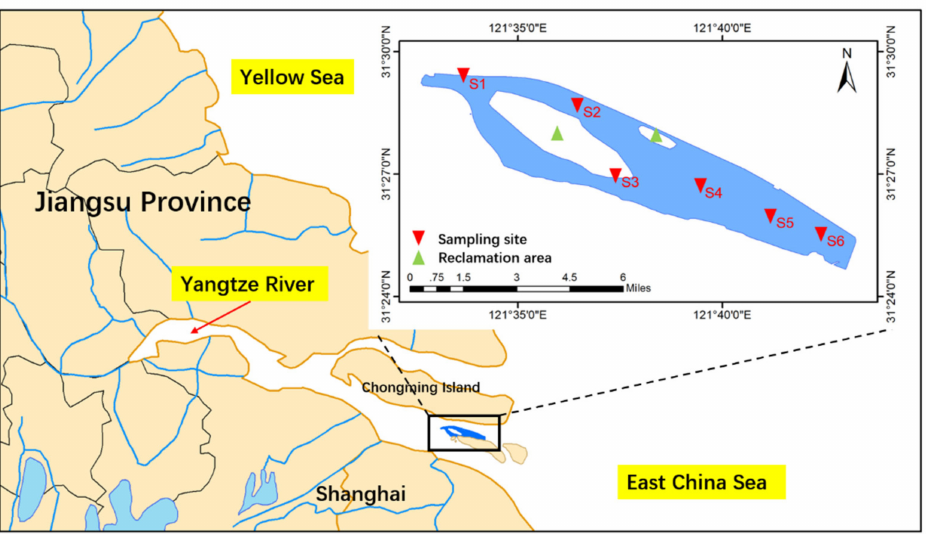
Figure 1. Location of the study area and sediment sampling sites in Qingcaosha (QCS) Reservoir, Shanghai,